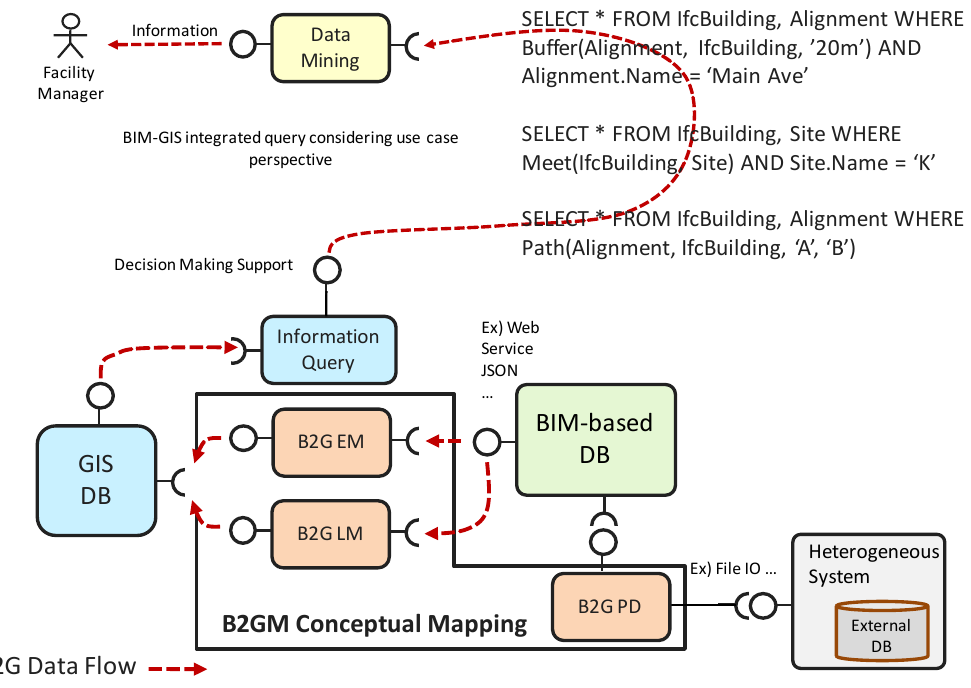
Figure 5. Database integration and query based on B2GM.